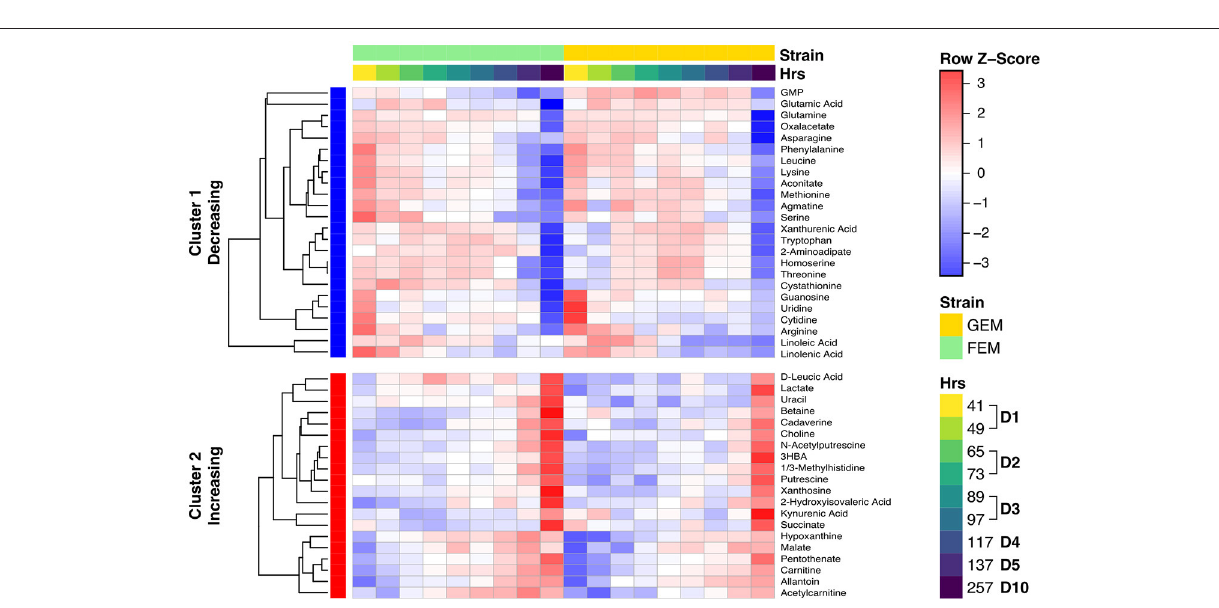
FIGURE 4 | Clustered heat map showing metabolite levels over time. The heat map shows row (metabolite) Z-scores, i.e., deviations from the average across time points for each metabolite. Each metabolite range is scaled so that it has mean of zero and standard deviation of one. Each time point represents the average for biological replicates. The samples are ordered first by strain (green is FEM, yellow is GEM), then by age. The row sidebar illustrates whether the metabolites have been determined to be increasing or decreasing with age (red for increasing, blue for